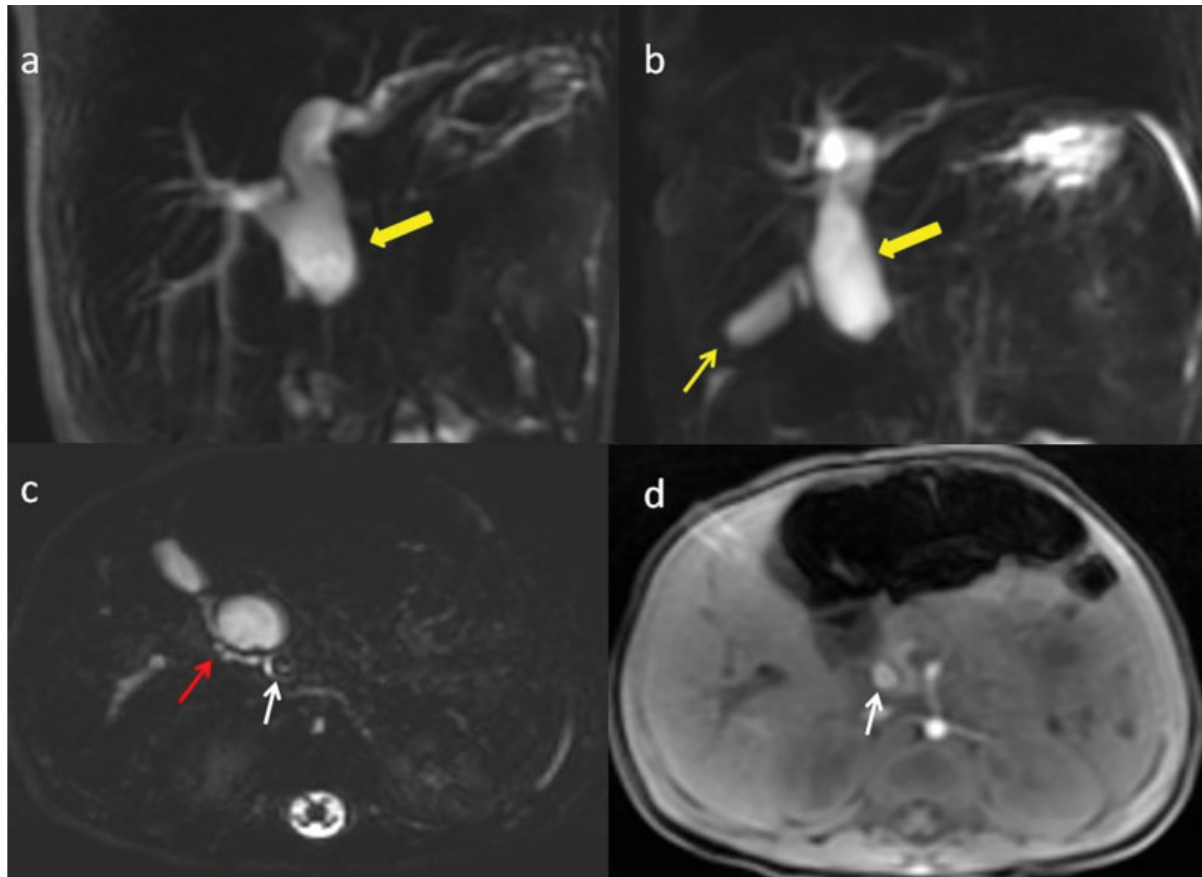
Fig. 2 MRIimagesofa3-month-oldinfantwithcholestaticjaundice.( a , b )2DMRCPshowingcysticdilatationofcommonhepaticduct(thickyellowarrow), andgallbladder(thinyellowarrow).( c , d )Axial3DMRCPandaxialT1-weightedMRimagesdepictingcourseanddrainageofcysticduct(redarrow)unusually distally and continuing as CBD which shows a T2 hypointense ( c ), T1 hyperintense ( d ) calculus (white arrow) within it respectively. 2D, two dimensional; 3D, three dimensional; CBD, common bile duct; MRCP, Magnetic resonance cholangiopancreatography; MRI, magnetic resonance